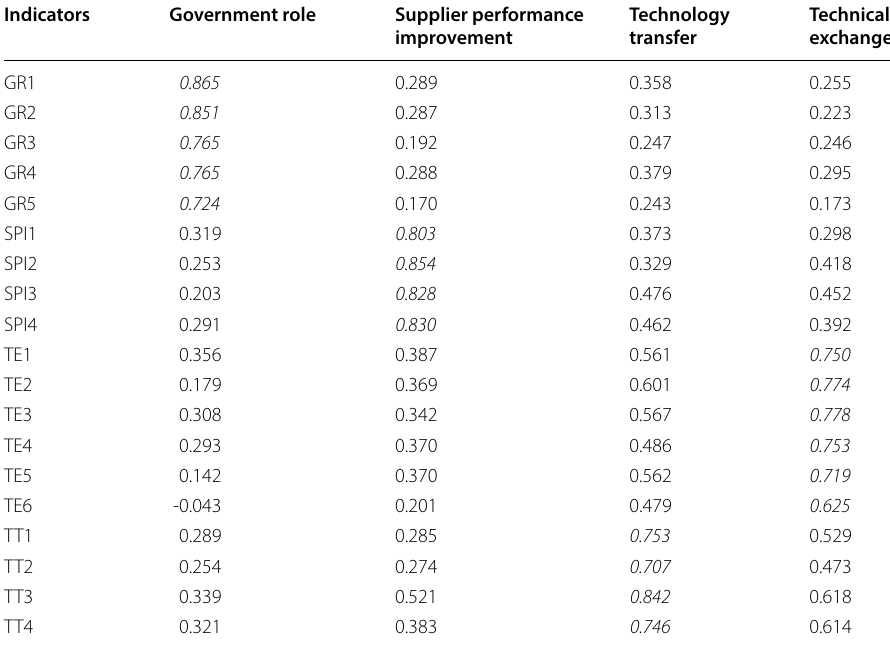
Table 6 Cross-loading. Source : Author data, Smart PLS